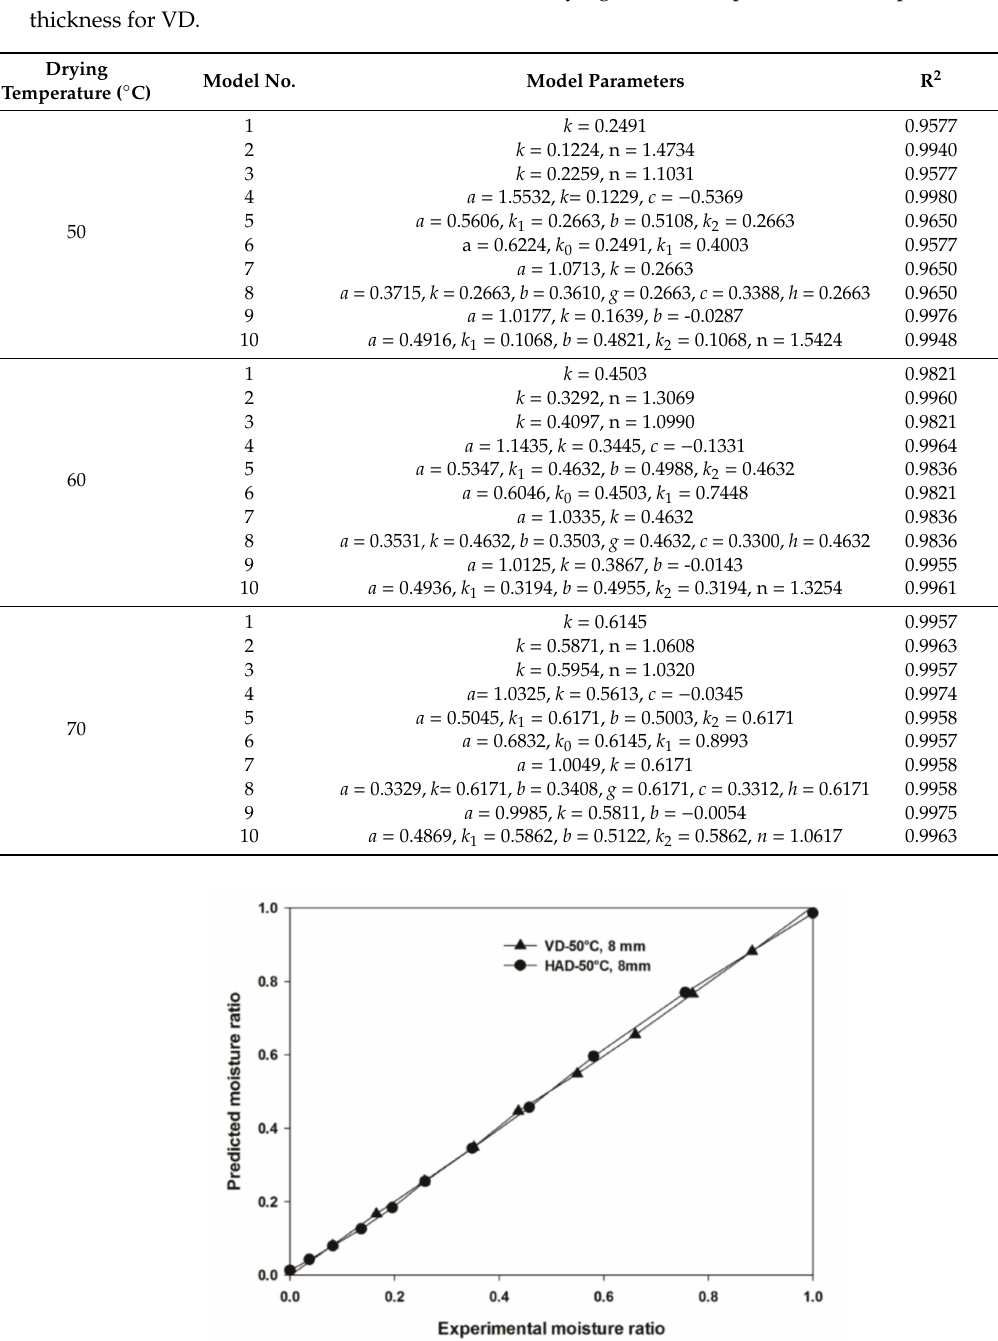
Figure 5. Predicted versus experimental moisture ratio data for logarithmic model at 50 ◦ C and 8 mm samples thickness for VD and HAD